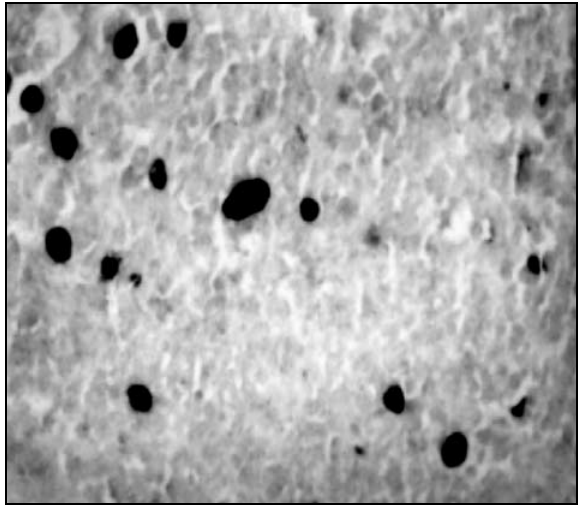
Figure 1 – Microscopic demonstration of EBV markers in classical Hodgkin’s lymphoma NS-subtype by in situ hybridization